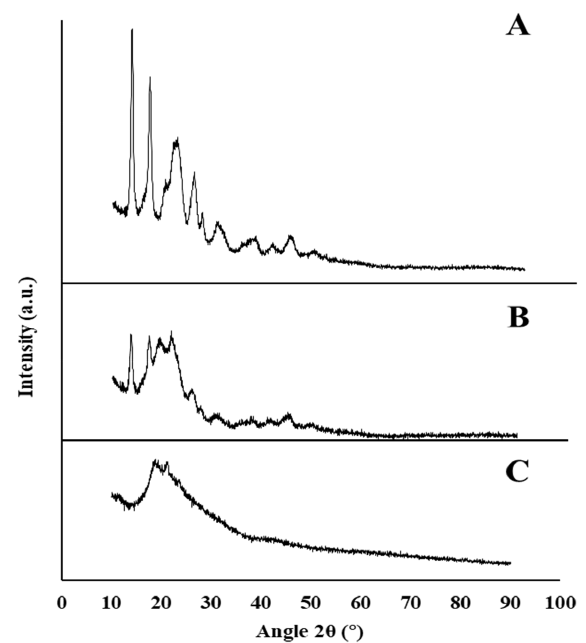
Figure 4. X-ray diffractogram of P(3HB) ( A ), P(3Hb)/mcl-PHA blend ( B ), and mcl-PHA ( C ) produced by C. necator DSM 428, the co-culture, and P. citronellolis NRRL B-2504, respectively, from apple pulp waste.